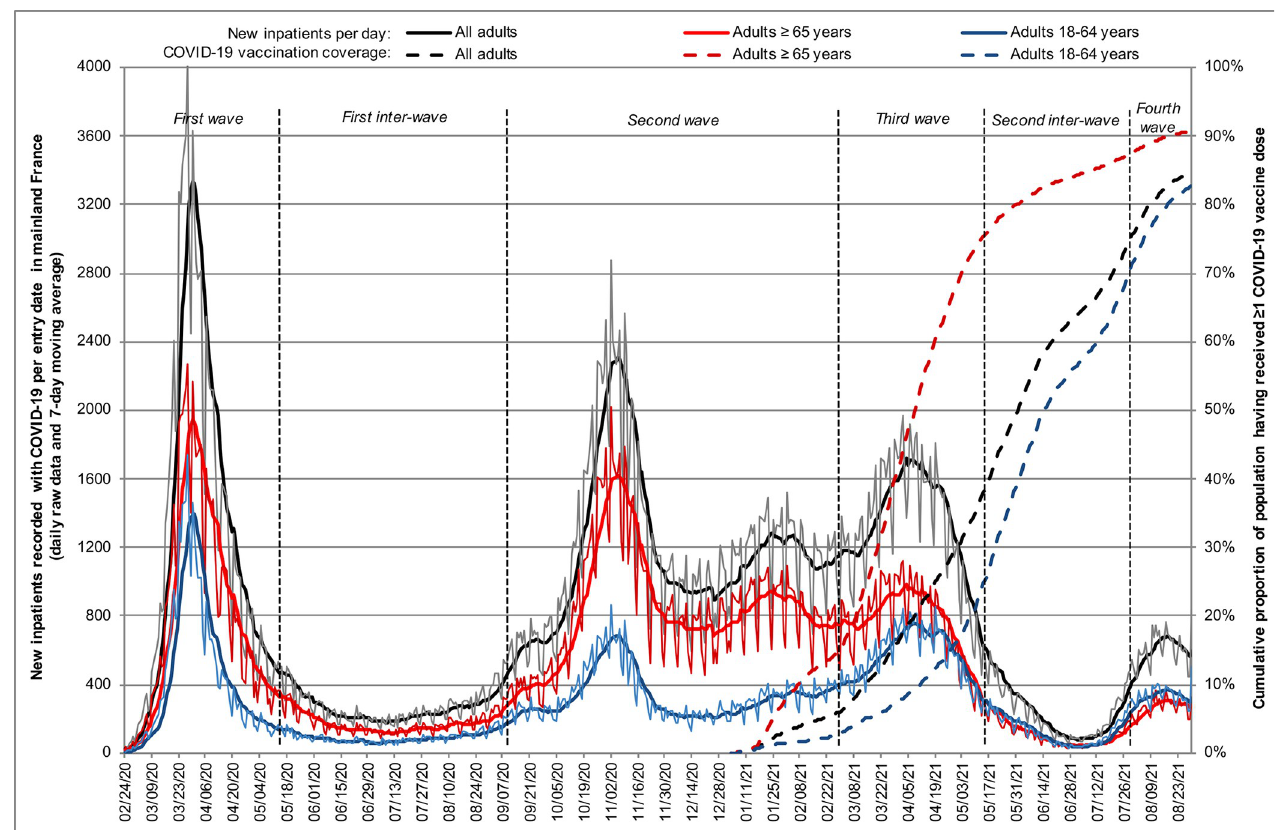
Fig 1. Burden of COVID-19 pandemic on French acute hospitals over 18 months ( n = 465,750).